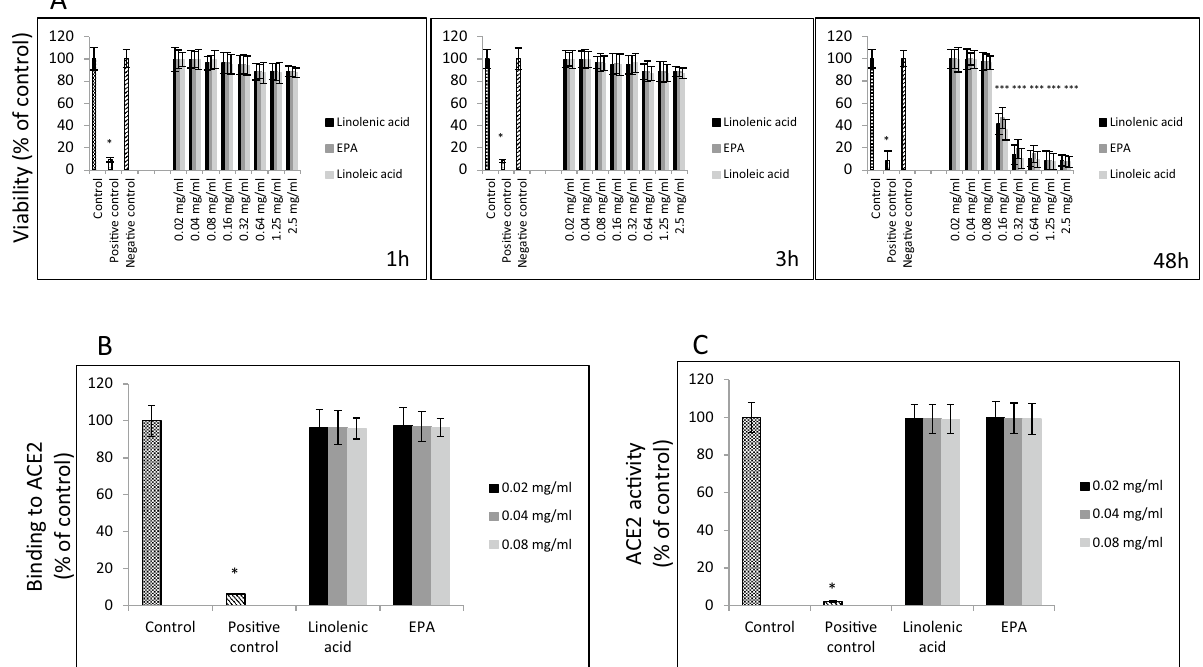
Figure 2. Effects of linolenic acid and EPA on viability of ACE2 expressing A549 cells and on human ACE2 receptor. ( A ) Viability of A549/hACE2 cells after 1 h, 3 h, and 48 h incubation with linolenic acid and EPA at different concentrations using MTT assay. Cell viability is expressed as change in absorbance at 570 nm in % compared to lipid-free control ± SD; positive control—100% dead cells, negative control—addition-free sample. ( B ) Binding of linolenic acid and EPA at indicated concentrations to hACE2 receptor (1.0 μg/ml) immobilized on the plate using human primary anti-ACE2 antibody at 1:500 dilution and HRP-conjugated secondary antibody at 1:1000 dilution, and measuring chemiluminescence signal. Data are presented as % of lipid-free control ± SD; control—0.025% DMSO, positive control—50% DMSO. ( C) Activity of hACE2 upon treatment with selected FAs and indicated concentrations. Purified hACE2 enzyme at 0.1 ng/µl was incubated with linoleic acid and EPA at different concentrations for 1 h at RT followed by addition of 25 µl fluorogenic substrate for 30 min. Fluorescence signal was measured at Ex/Em = 535/595 nm using spectrofluorimeter. Data are presented as % of lipid-free control ± SD; * p ≤ 0.001. Control—0.025% DMSO, positive control—10%